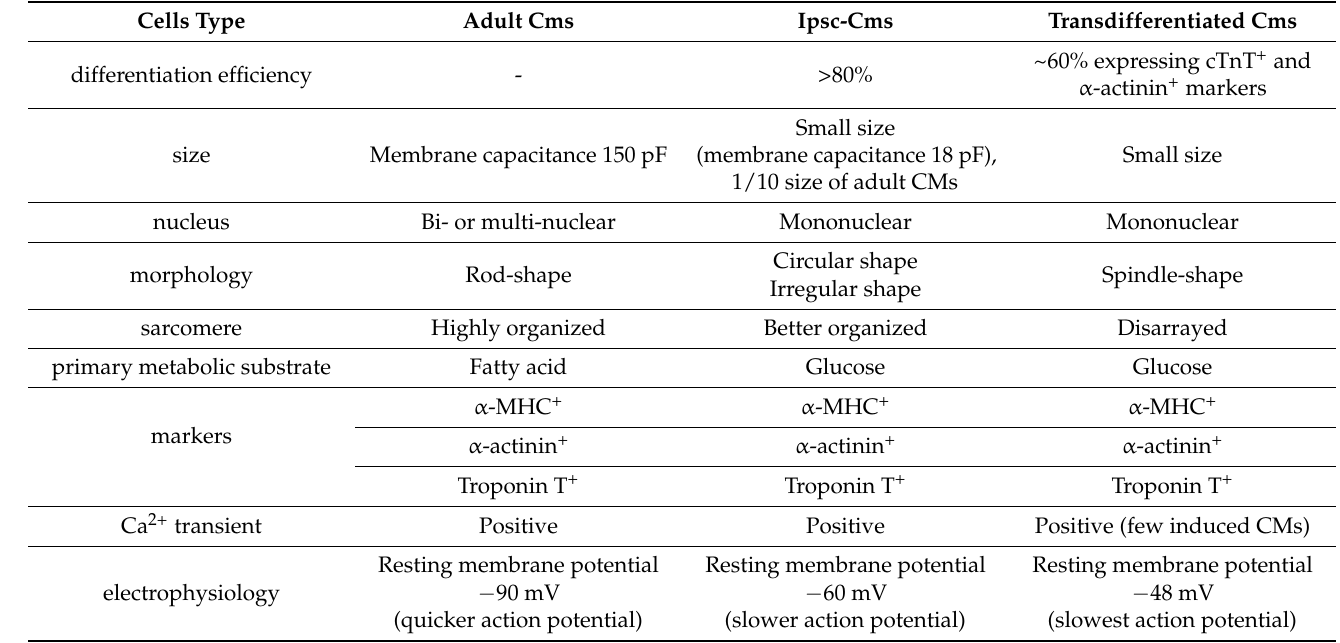
Table 3. Characteristics of adult cardiomyocytes (CMs), iPSC-CMs and cardiomyocytes transdifferentiated from somatic cells.